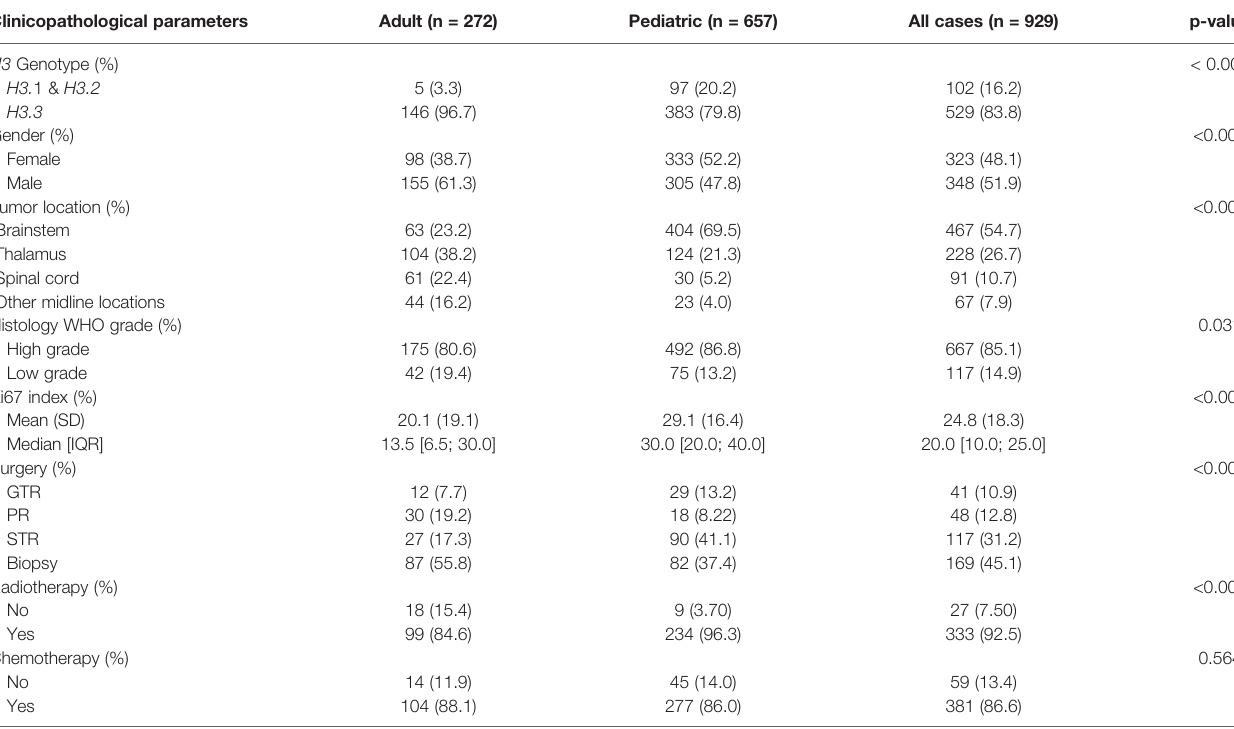
TABLE 1 | The clinicopathological parameters of pediatric versus adult H3 K27M-mutant midline gliomas. Clinicopathological parameters Adult (n = 272) Pediatric (n = 657) All cases (n = 929) p-value H3 Genotype (%)